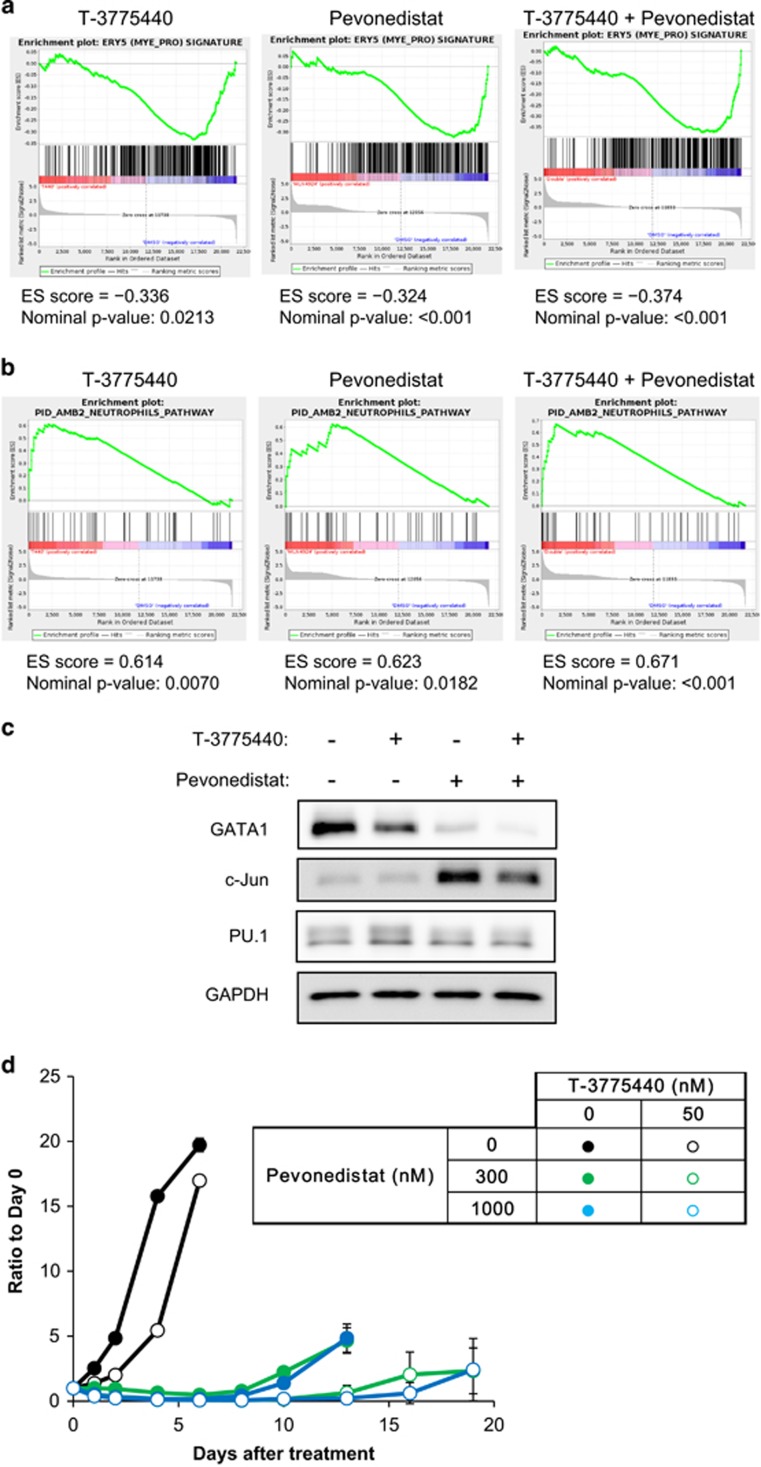
Cotreatment with T-3775440/pevonedistat results in AML cell transdifferentiation and durable growth suppression. (a, b) TF-1a cells were treated with vehicle, 50 nm T-3775440, 1000 nm pevonedistat or T-3775440 and pevonedistat in combination for 24 h. Total RNA was used for microarray analysis. Gene set enrichment plots demonstrate the downregulation of erythroid signature genes (a) and upregulation of neutrophil signature genes (b). (c) TF-1a cells were treated with T-3775440 and pevonedistat as indicated. Whole-cell lysates were prepared and subjected to immunoblotting analysis. Glyceraldehyde 3-phosphate dehydrogenase (GAPDH) was used as a loading control. (d) Cell proliferation assay after washout of compounds. TF-1a cells were treated with the indicated drugs alone or in combination for 72 h. Cells were then replated in the absence of the compounds and proliferation rates were determined using CellTiter Glo assay (n=3).